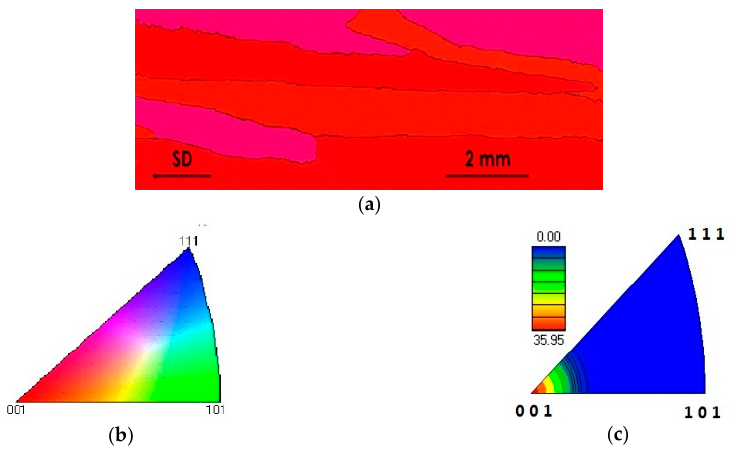
Figure 2. ( a ) Electron back-scattered diffraction (EBSD) quasi-colored orientation map along solidification direction (SD); ( b ) the reference stereographic triangle; ( c ) inverse pole figure along the SD, which illustrate that the columnar-grained Cu 71 Al 17.5 Mn 11.5 SMA sample has a strong <001>-oriented texture along the SD.